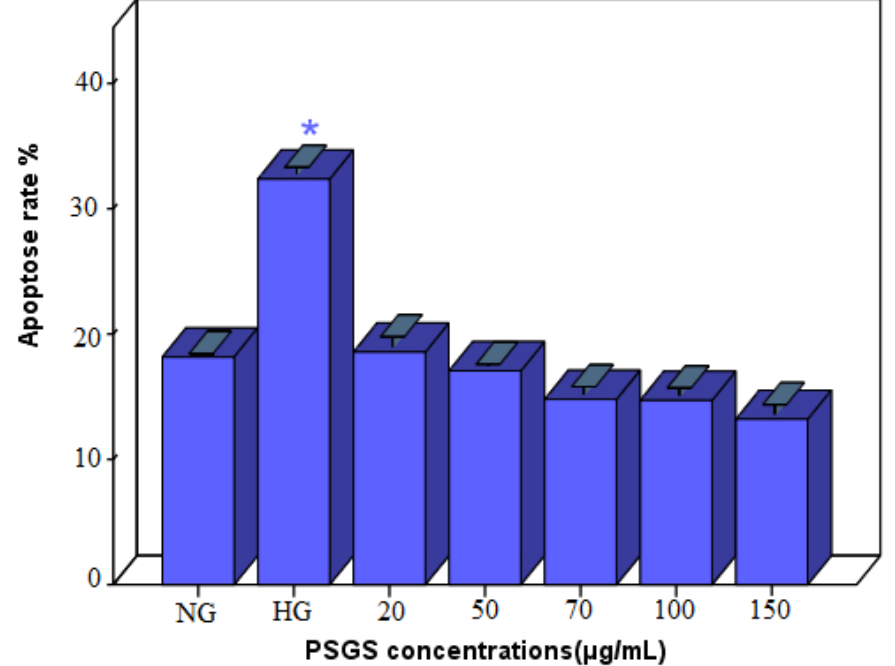
Figure 8. Effect of PSGS on H 2 O 2 -induced apoptosis. NG (normal group) HG (treated group with H 2 O 2 ). Error bars represent standard deviations of three replications, Significant differences between the treated groups and the control were mentioned as follows: * p < 0.05.